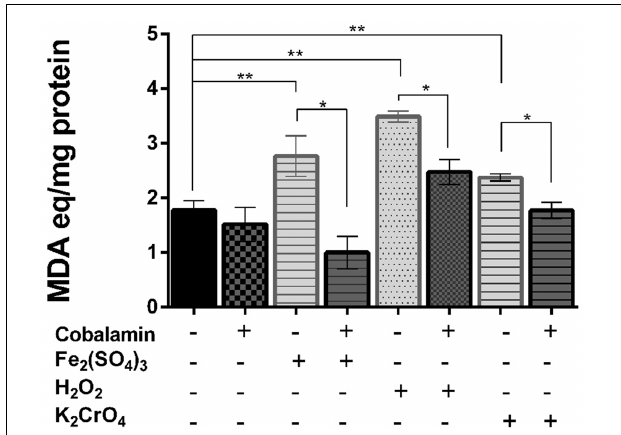
FIGURE 2 | Effect of cobalamin on lipid peroxidation. Lipid peroxidation products, expressed as malondialdehyde (MDA) equivalents, were determined as thiobarbituric acid-reactive substances present in crude extracts in Leptospirillum CF-1 cells as indicated under Section “Materials and Methods.” Bars represent the average of three independent experiments ± standard deviations. ∗ P < 0.05, ∗∗ P <